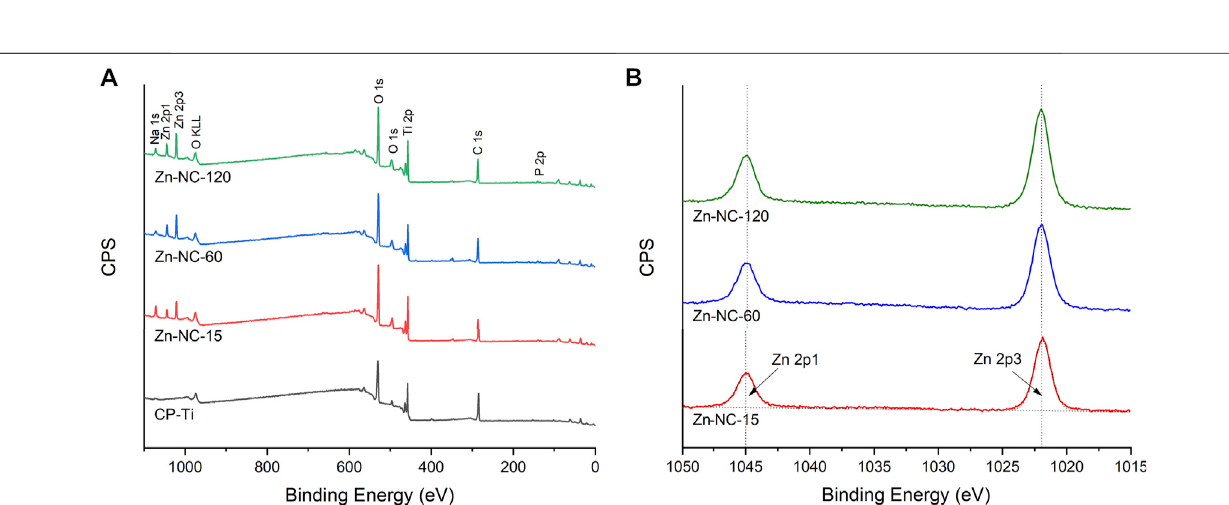
Frontiers in Materials |